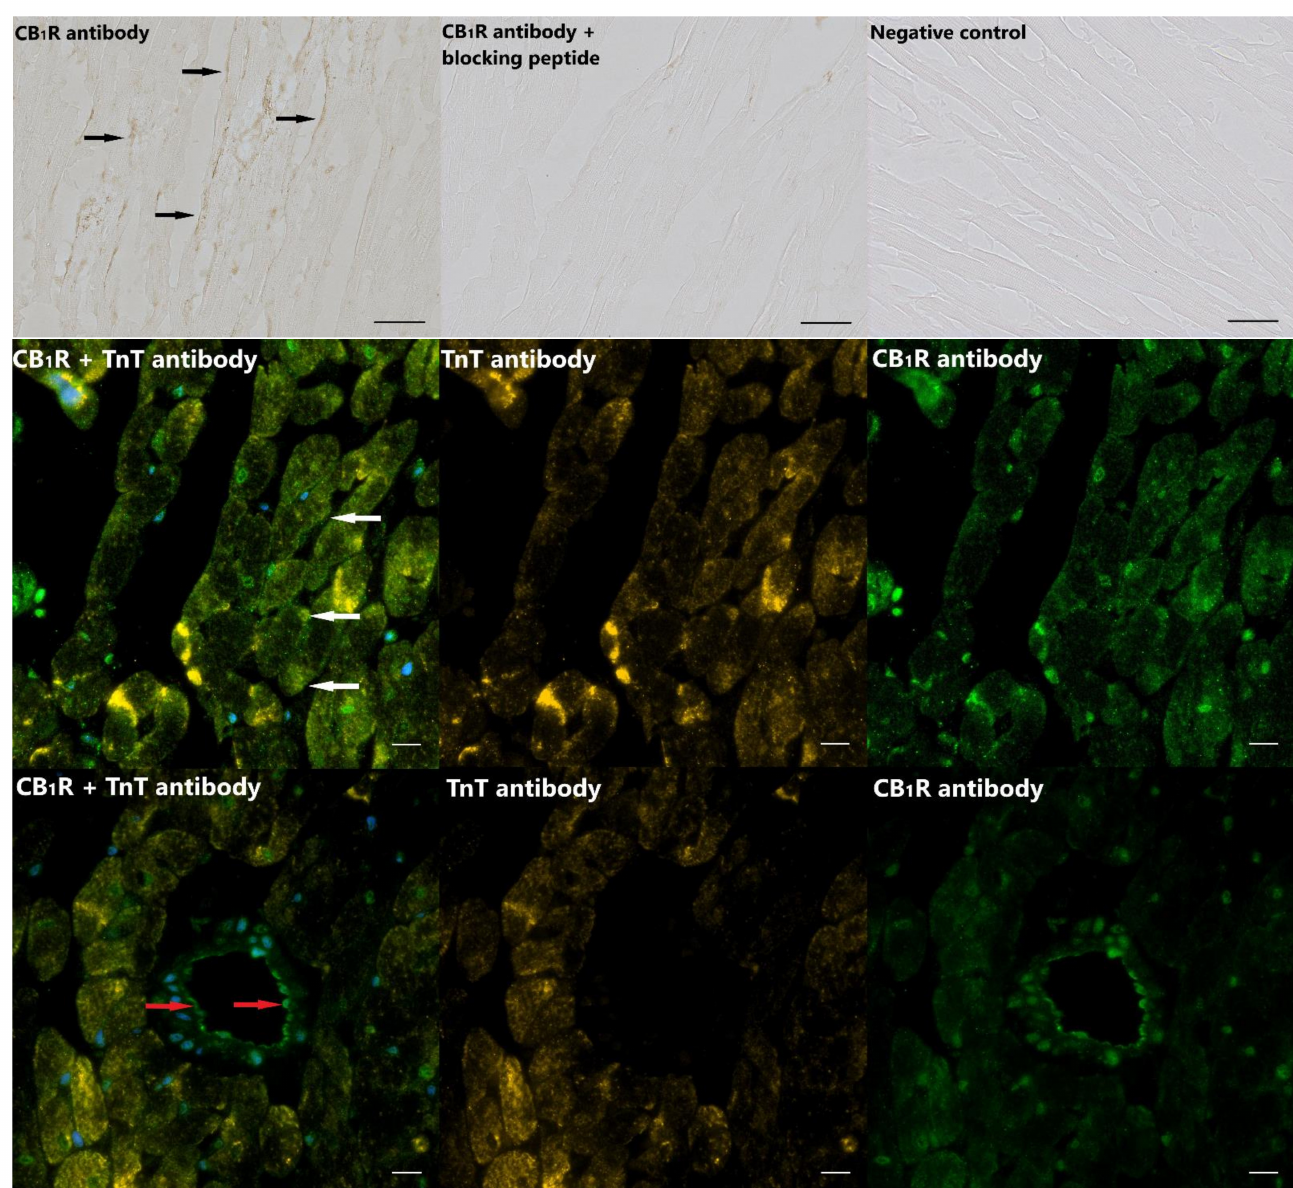
Figure 1. Type-1 cannabinoid receptor (CB 1 R) expression and localization in rat cardiac tissue. Upper panel: Immunohisto- chemical localization of the CB 1 R protein in cardiac tissue of rats (black arrows). No staining was detected in the absence of the primary antibody (negative control), and a robust decrease in immunostaining was observed when the CB 1 R primary antibody was applied together with blocking peptide; scale bar: 20 µ m. Middle and lower panels: Immunofluorescent stain- ing of CB 1 R (green) and cardiac Troponin T (TnT, orange) revealed CB 1 R localization on the sarcolemma of cardiomyocytes (white arrows). CB 1 R staining was also detectable in the wall of vessels (red arrows); scale bar: 10 µ